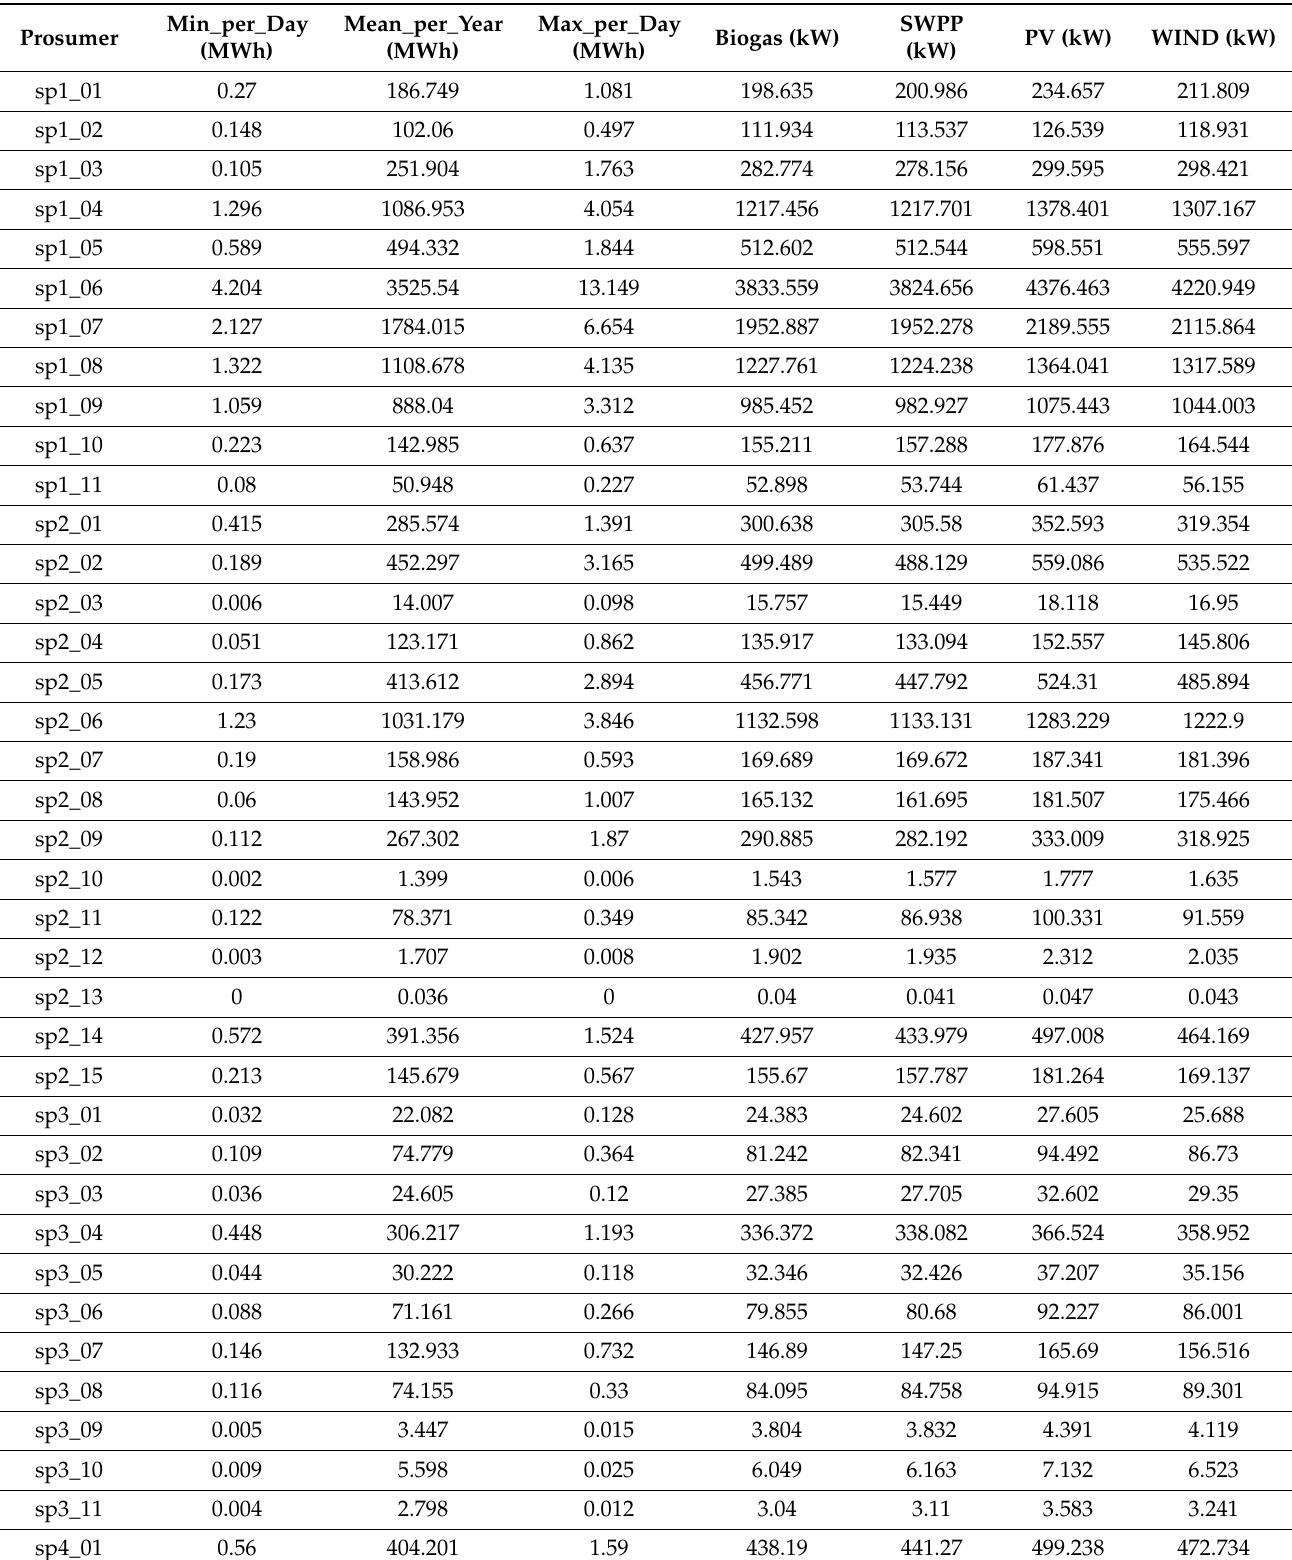
Table 2. Limit (minimum required) values of generating sources at prosumers which guarantee energy